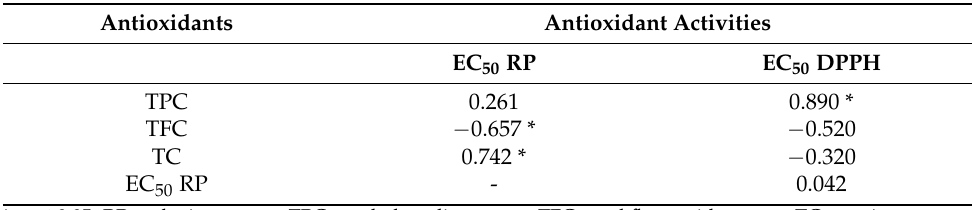
Table 6. Results of the correlation analysis between measured antioxidant activities of prickly pear seeds and the classes of antioxidants monitored. Antioxidants Antioxidant Activities EC 50 RP EC 50 DPPH TPC 0.261 0.890 * TFC − 0.657 * − 0.520 TC 0.742 * − 0.320 EC 50 RP - 0.042